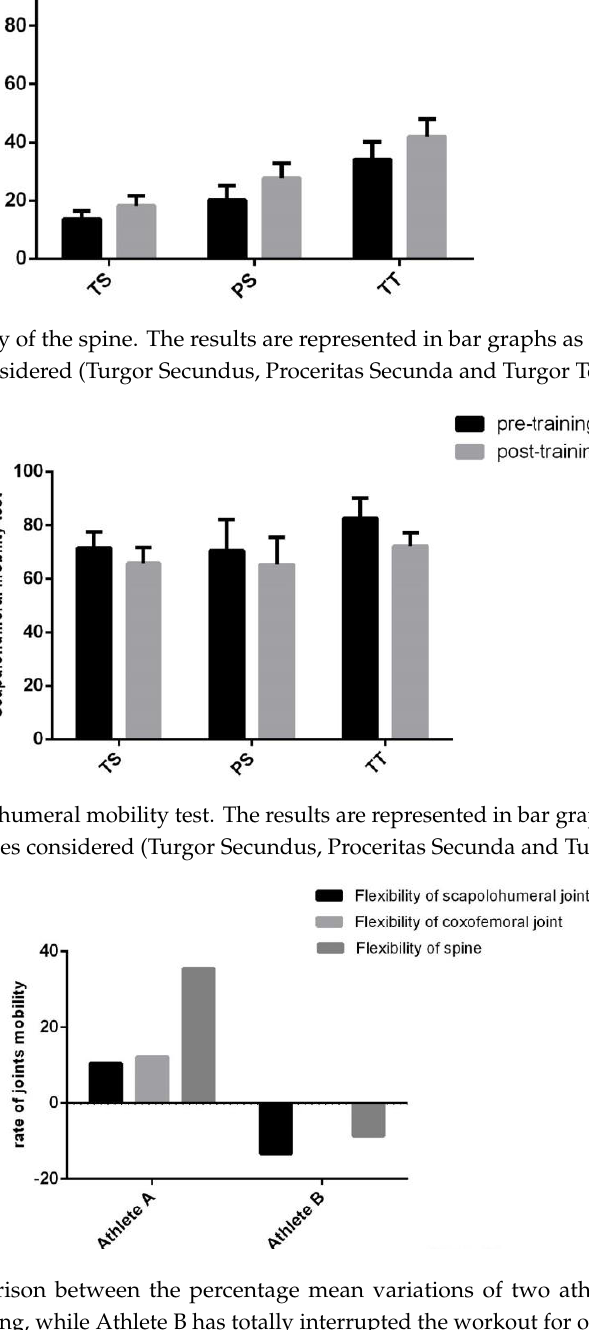
Figure 12. Comparison between the percentage mean variations of two athletes: Athlete A has completed the training, while Athlete B has totally interrupted the workout for one and a half months.